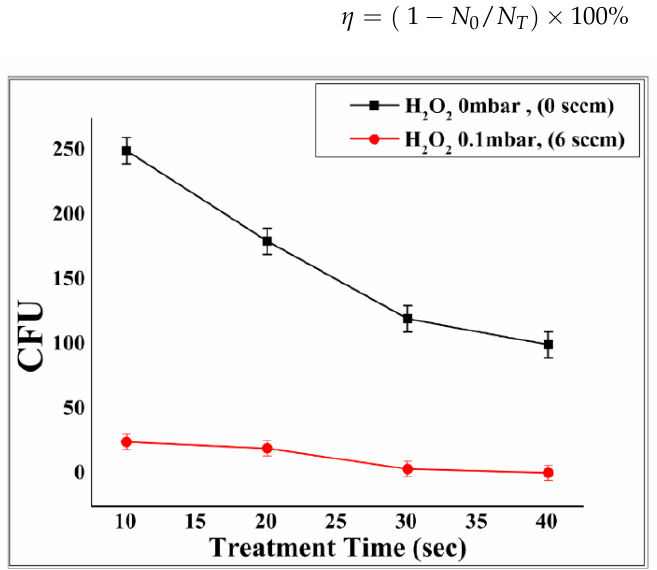
Figure 5. Dependence of V. cholera on treatment time and H 2 O 2 .